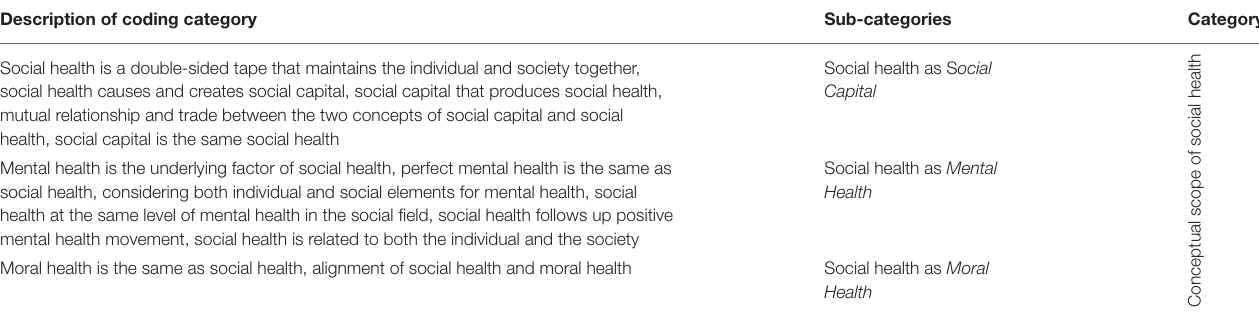
TABLE 3 | Categories, sub-categories and codes obtained from interviews with participants. Description of coding